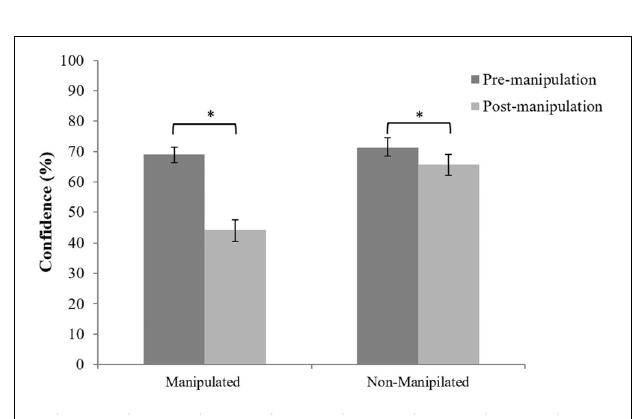
FIGURE 5 | Identification confidence rates before (pre-manipulation) and after (post-manipulation) the presentation of the manipulated outcome and as a function of manipulation status. Error bars represent bootstrapped 95% confidence intervals. Asterisk represents a statistically significant difference ( ∗ p <